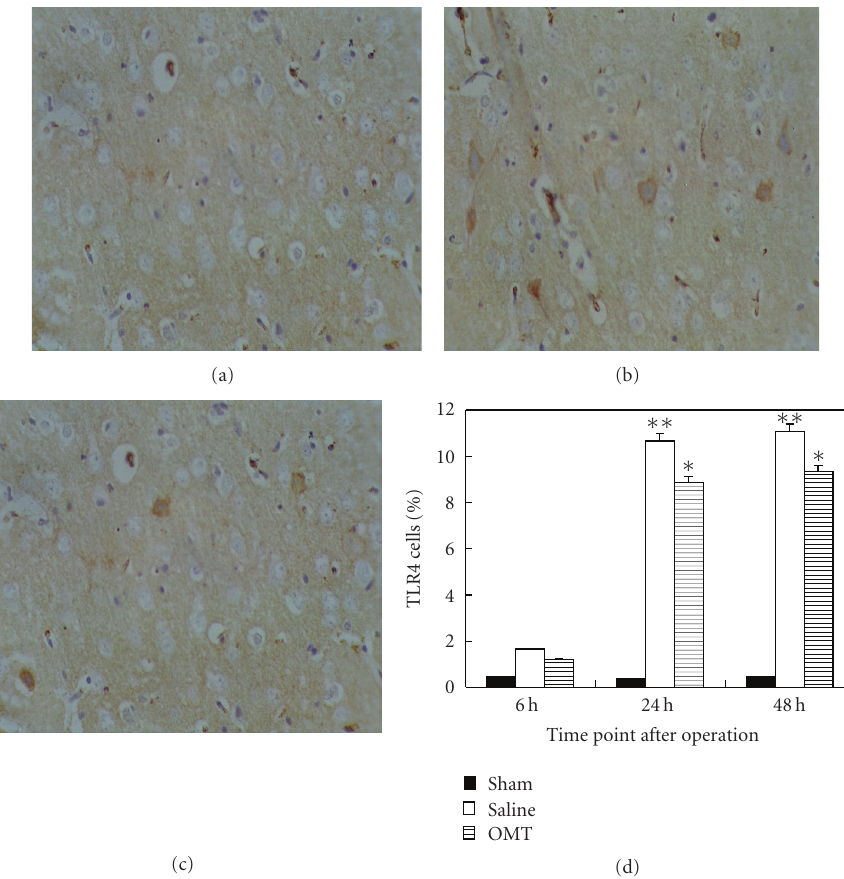
Figure 5: TLR4 expression detected by immunohistochemistry. (a) TLR4 expression in the sham group: TLR4 expression could not be observed in the sham group at 24 hours. (b) TLR4 expression in the saline group: TLR4 expression evidently increased in the saline group at 24 hours. Positive cells were defined as having bu ff y grains in the cytoplasm. (c) TLR4 expression in the OMT treatment group: TLR4 expression decreased relatively in the OMT treatment group at 24 hours. (d) TLR4 expression in each group at all time points: TLR4 expression showed no di ff erence among all the test groups at 6 hours. It was evidently higher in the saline group at 24 hours and lasted up to 48 hours. Compared with the saline group at identical time points, TLR4 expression was lower in the OMT treatment group, and the di ff erence was significant ∗∗ P < . 01 and ∗ P < . 05 compared with Sham.